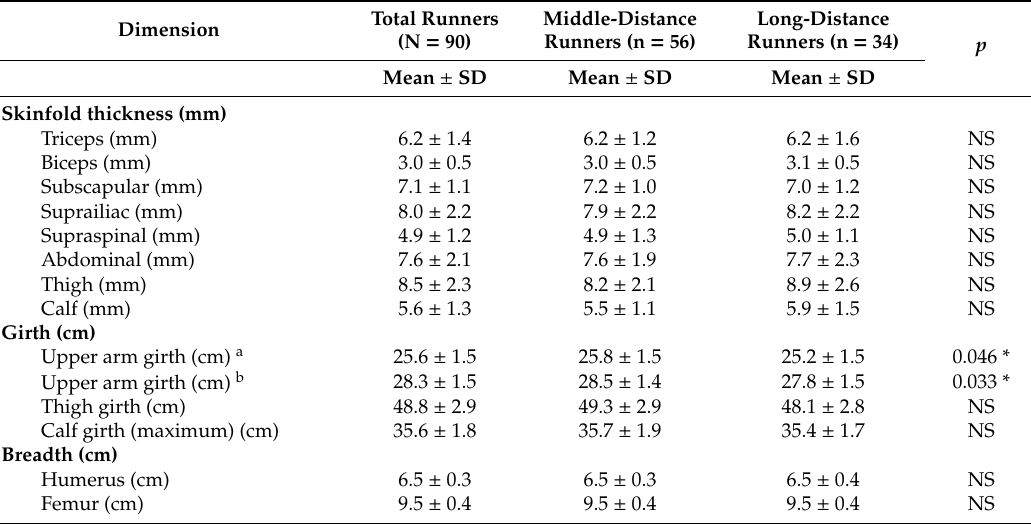
Table 2. Anthropometric characteristics, body composition and somatotype for young elite runners, (mean ± SD) and di ff erences between middle-distance and long-distance runners.